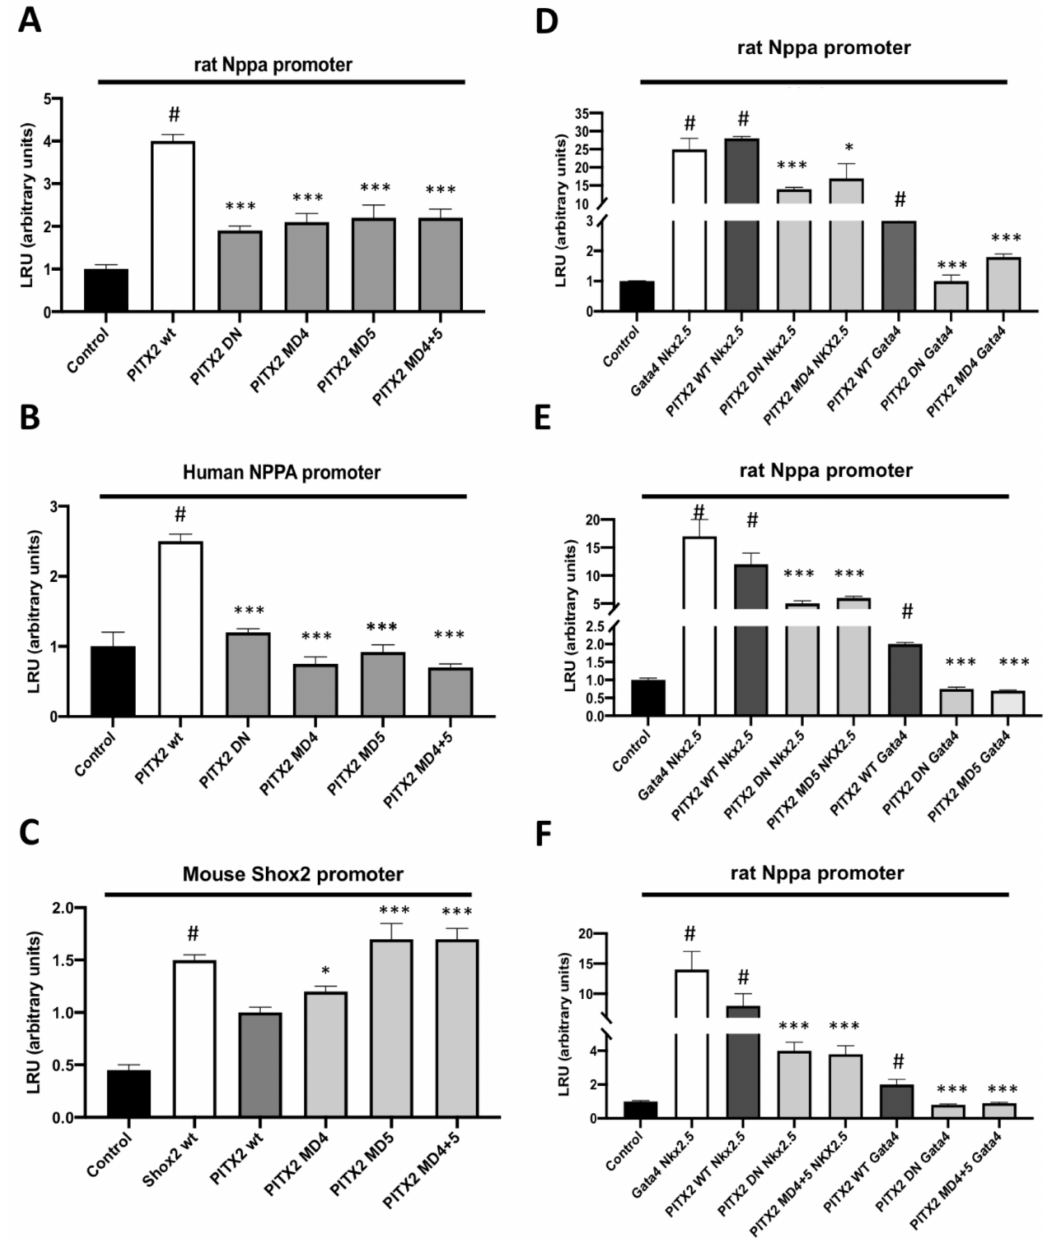
Figure 2. Pitx2 transactivation assays. Panel ( A ). PITX2 transactivation assays of the PITX2 wild type, DN, MD4, MD5 and MD4+5 constructs within the rat Nppa promoter. Observe that PITX2c wild type significantly enhanced luciferase expression as compared to controls, while PITX2 DN, MD4, MD5 and MD4+5 constructs significantly decreased their transactivation